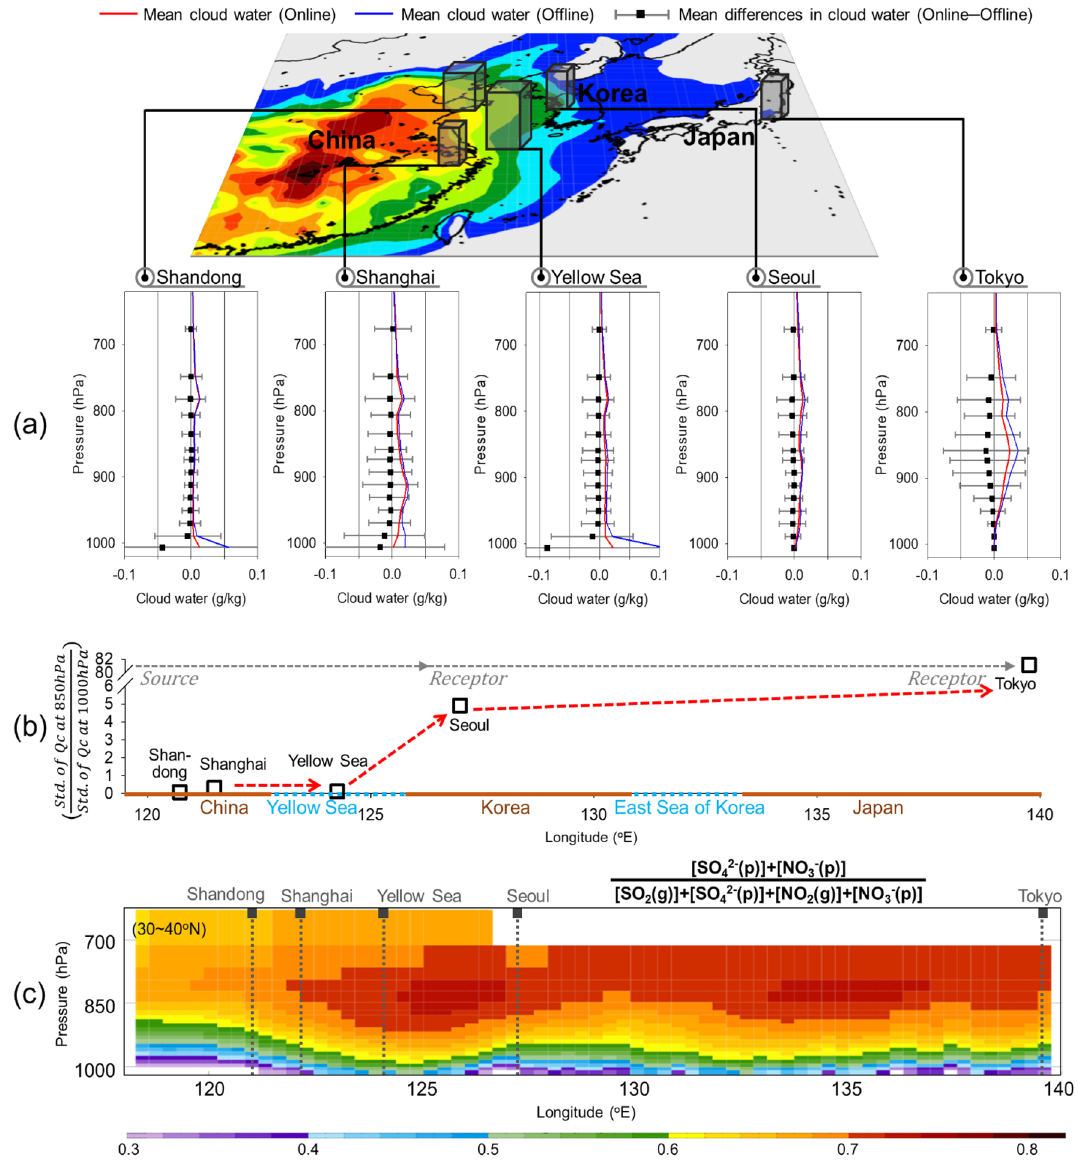
Figure 5. ( a ) Vertical profiles of online (red solid line) and offline (blue solid line) WRF-Chem-simulated cloud water mixing ratios from the ground to 600 hPa isobaric surface in Shandong, Shanghai, the Yellow Sea, Seoul, and Tokyo averaged from March to April 2018. The black squares and grey horizontal lines represent the mean and standard deviation of cloud water differences between online and offline WRF-Chem modelling results, respectively. ( b ) The ratio of standard deviations of cloud water differences between 850 and 1000 hPa in Shandong, Shanghai, the Yellow Sea, Seoul, and Tokyo. ( c ) Vertical distributions of gas-to-particle conversion ratios of sulfate and nitrate simulated by online WRF-Chem modelling. The separated sulfate and nitrate oxidation ratios are also illustrated in Figure